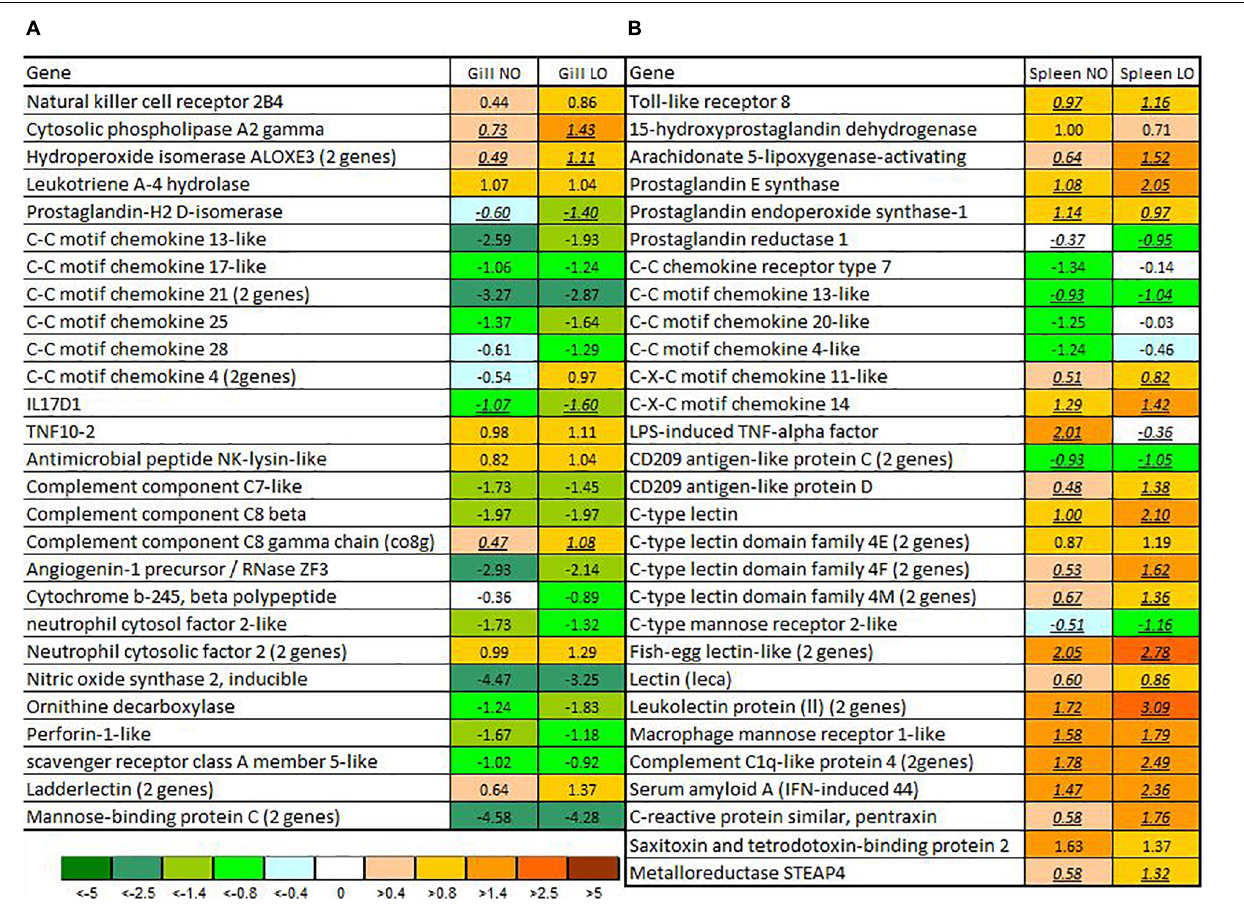
FIGURE 6 | Immune genes with responses to M. viscosa in either gill (A) or spleen (B) . Data are log 2 -ER (expression ratios of infected to uninfected). Differential expression is indicated with underlined italics. NO, LO – groups maintained at normal and low dissolved oxygen. The numbers of paralogs are indicated in